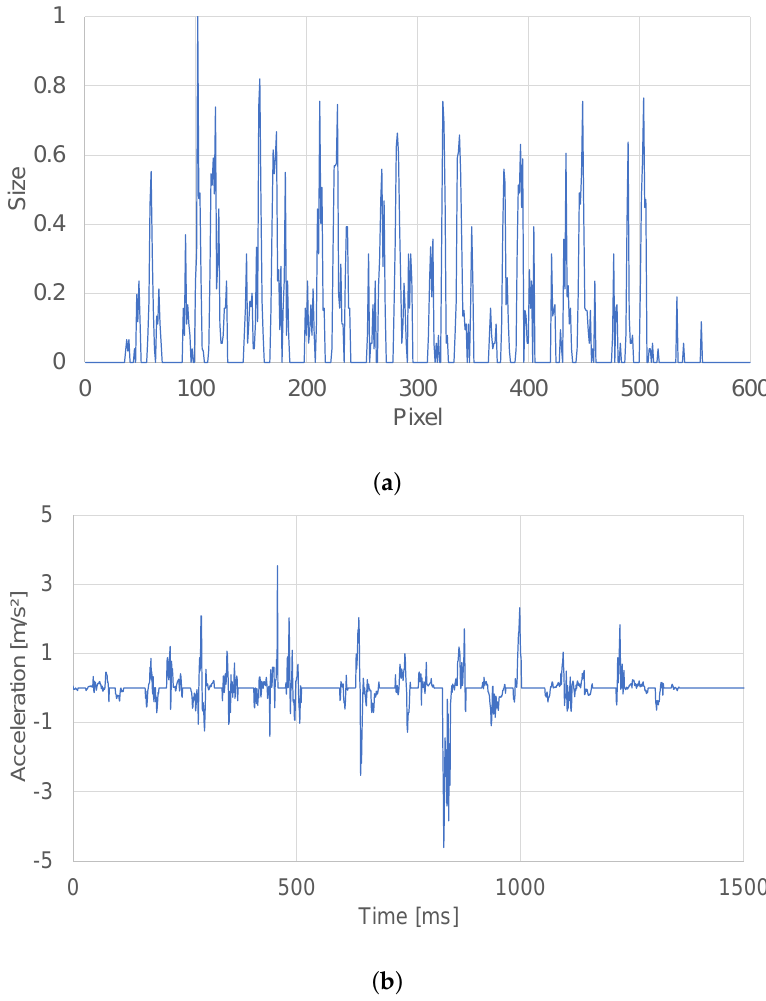
Figure 6. ( a ) Vibration information of self-made tile texture, ( b ) Vibration information with the parameter e ( x )